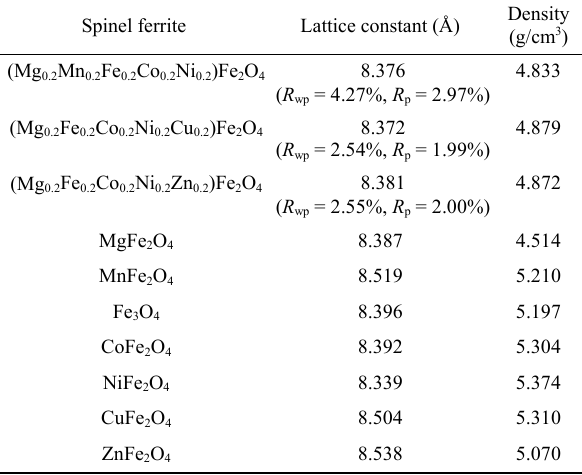
Table 2 Lattice constants and theoretical densities of HE MFe 2 O 4 and those of several typical spinel ferrites Spinel